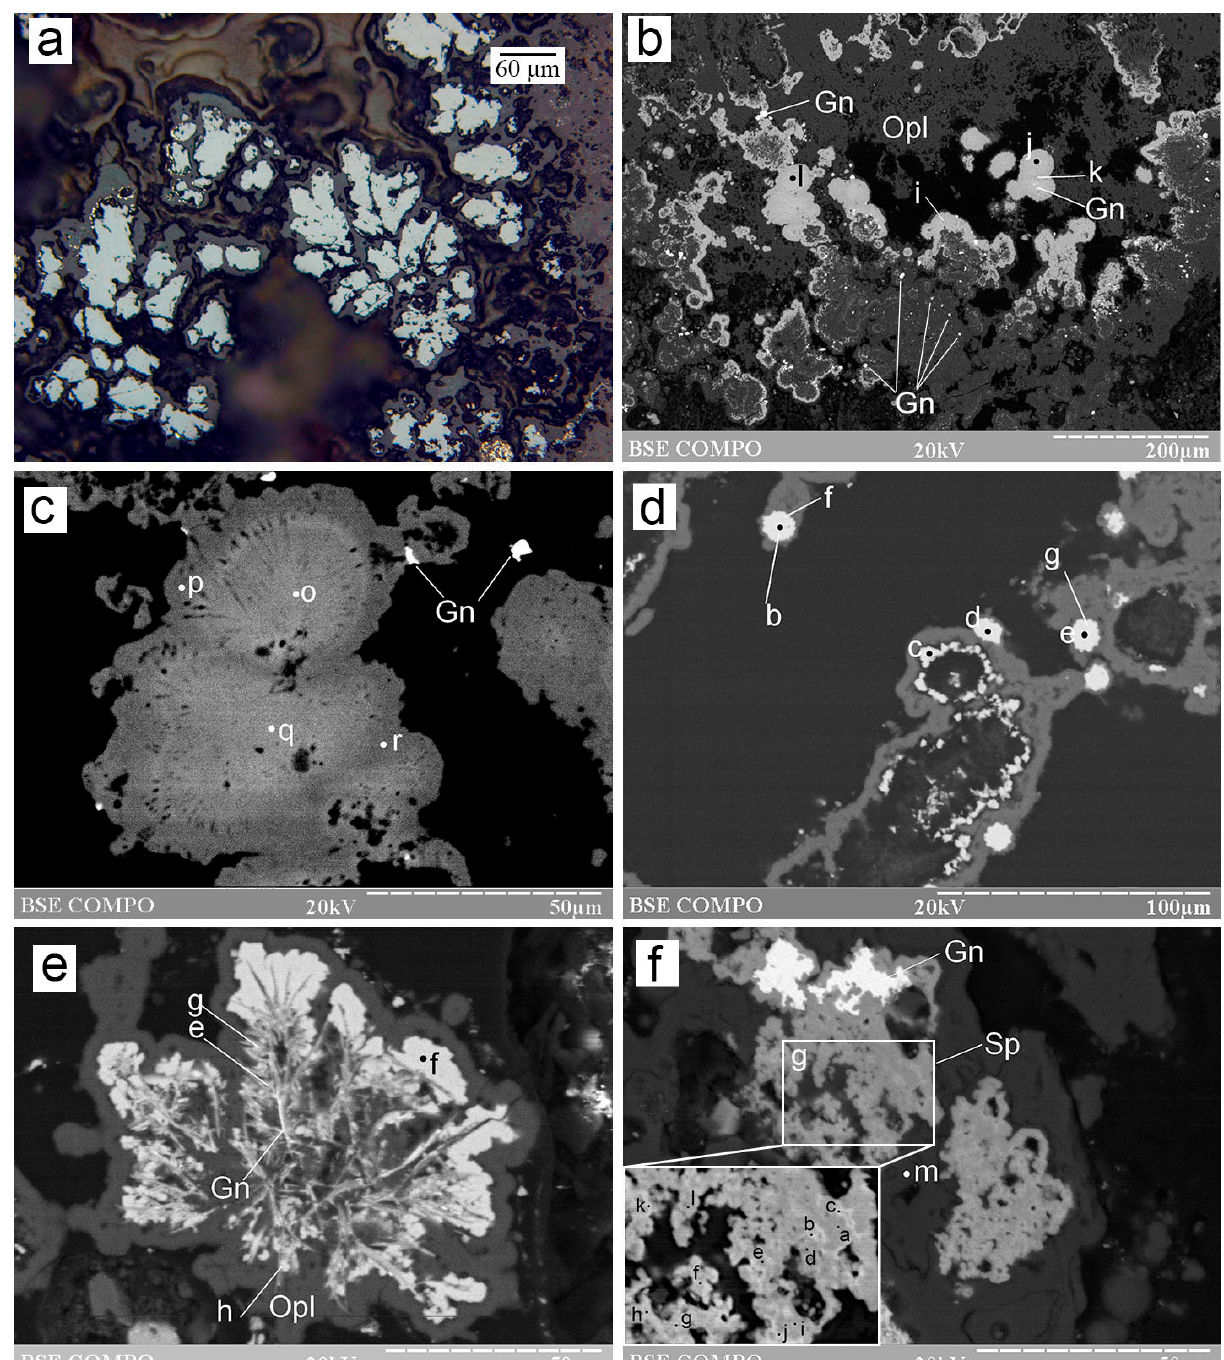
Figure 4. Morphology of sphalerite from the Irinovskoe HSF: ( a ) Dendritic sphalerite rimmed by opal with tiny pyrite grains; ( b ) Zoned opal–sphalerite aggregates with reniform sphalerite and galena crystals on top and numerous galena inclusions in opal; ( c ) Zoned reniform sphalerite ag- gregate with a Pb- and Ag-rich center and a Pb- and Ag-poor rim; ( d ) Sphalerite framboids (points b, f, g and e) rimmed by opal (point c); ( e ) Dendrites of Fe-, Cd-, Co- and Pb-bearing acicular sphalerite (points g and e) and galena overgrown by Fe-rich crystalline sphalerite (points f and h); ( f ) Anhedral Cd-rich sphalerite aggregates (Sph) with galena (bright) surrounded by opal ( point m); ( g ) Detail of the previous image: veinlets of sphalerite with high Cd contents (all points except for a and d) in sphalerite with lower Cd contents (points a and d). Images: reflected light ( a ); BSE (others). Sample numbers: 241-2/1-11 ( a – c , f , g ), 241-2/2-2 ( d , e ).